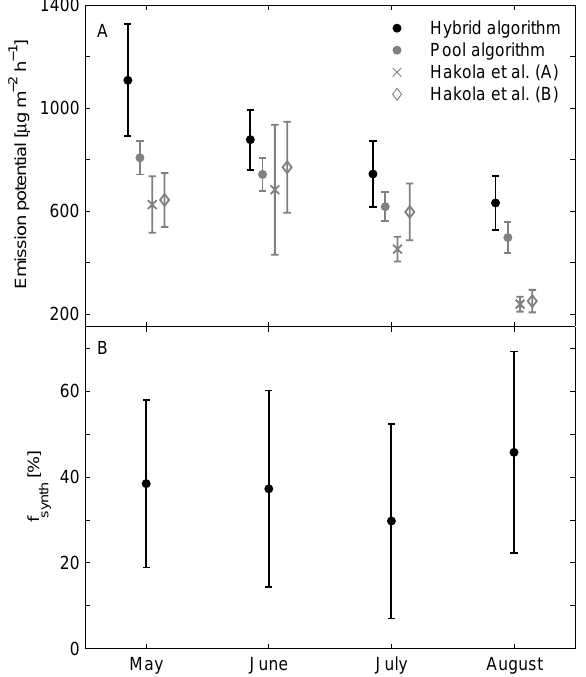
Fig. 3. (A) Monthly variation in the total emission potential and the pool emission potential during the summer 2007. The pool emission potentials based on measurements with two Scots pine branches were derived from the results of Hakola et al. (2006) using a needle biomass density of 540gm − 2 . (B) Ratio of the de novo emission potential to the total emission potential ( f synth ). The error bars rep- resent the 95% confidence